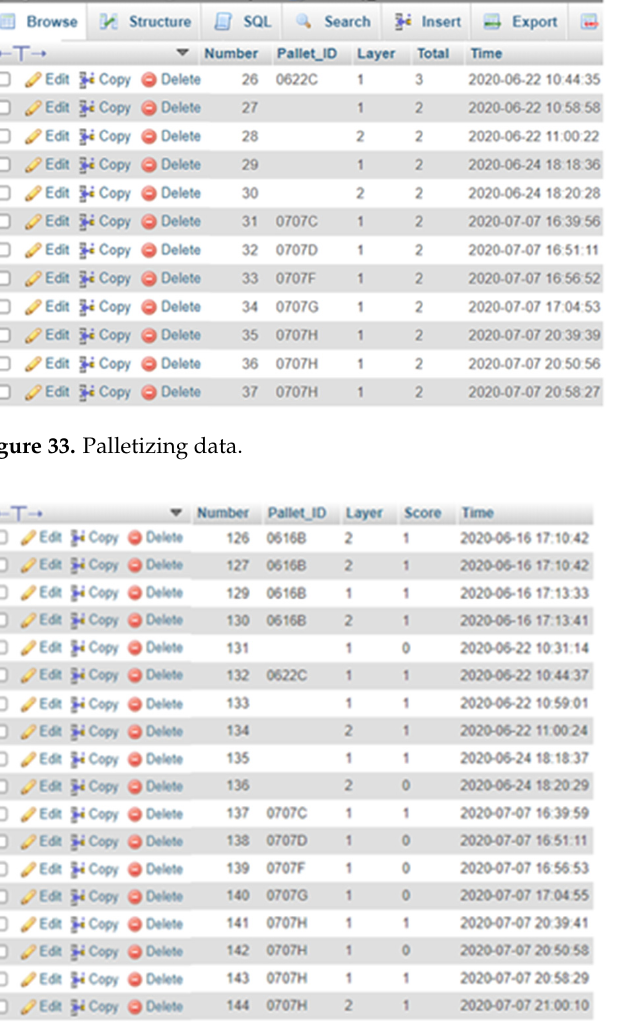
Figure 34. Vision system data.